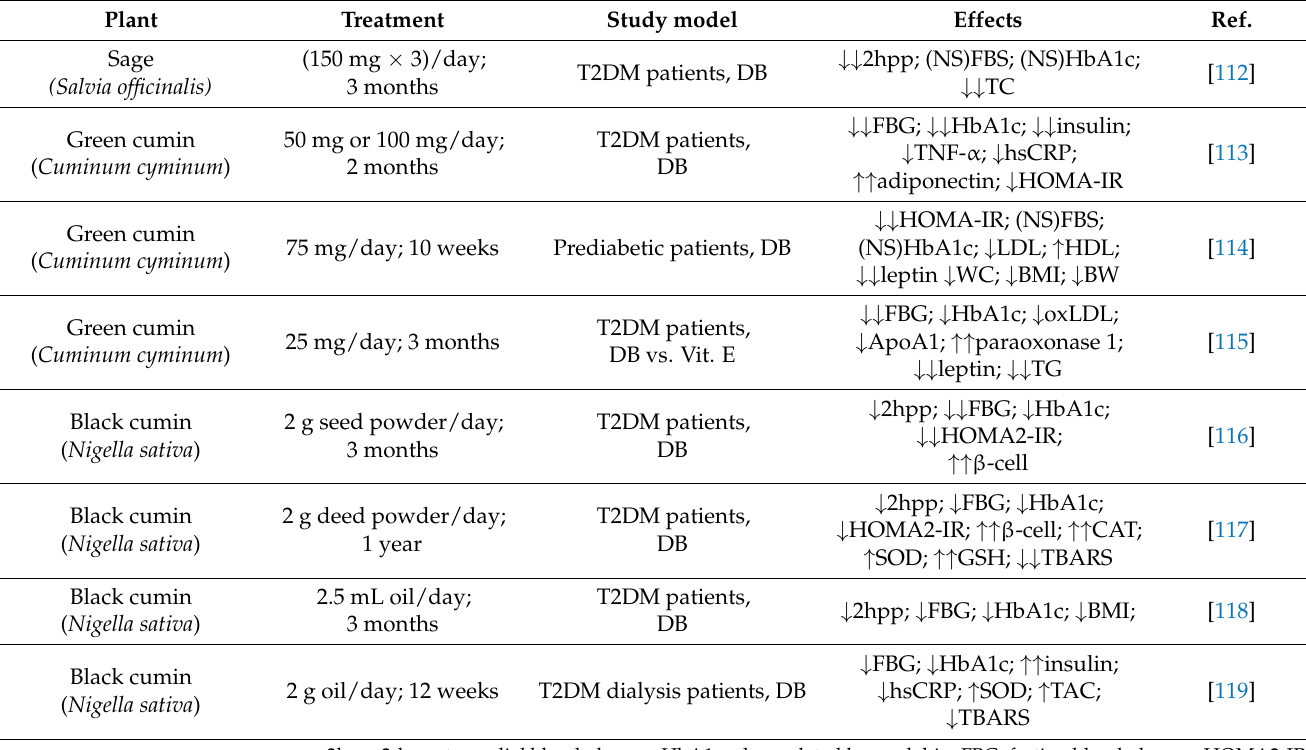
Table 1. Representative clinical trials of essential oils in the treatment of hyperglycemia. Plant Treatment Study model Effects